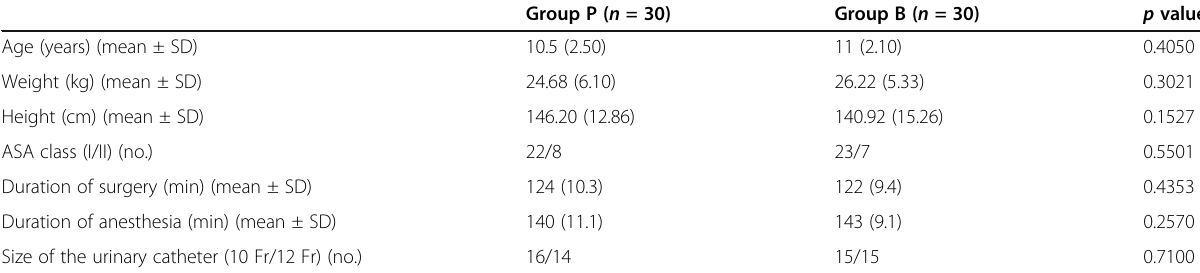
Table 1 Demographic